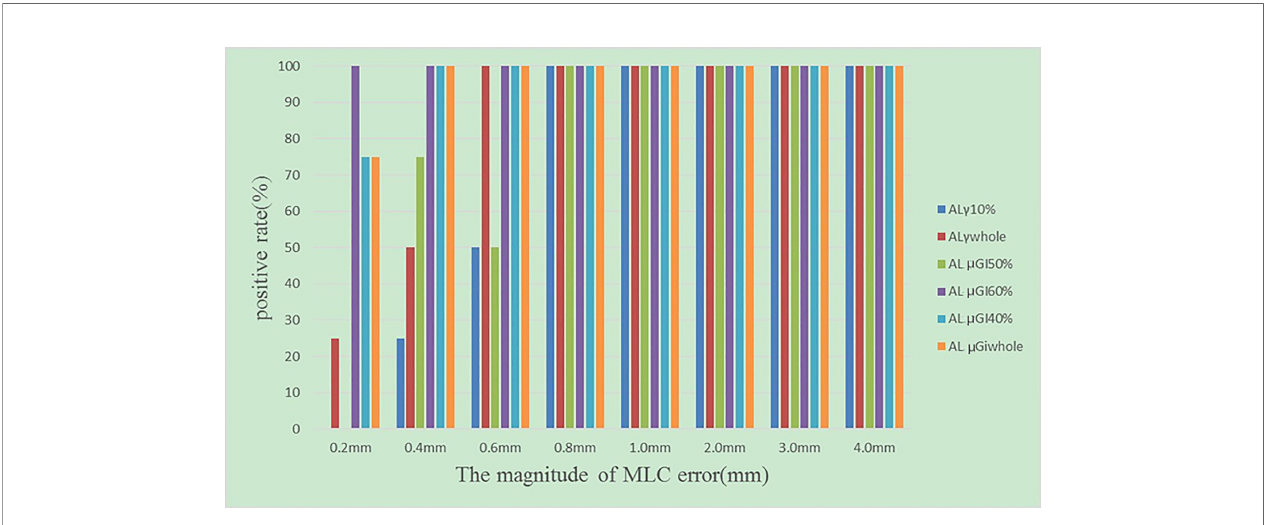
FIGURE 8 | The positive rates of test plans introduced with different magnitudes of systematic MLC